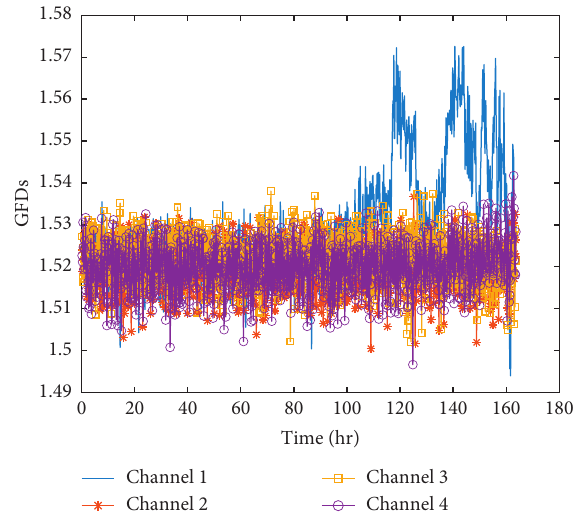
Figure 9: Temporal distribution of GFDs of different